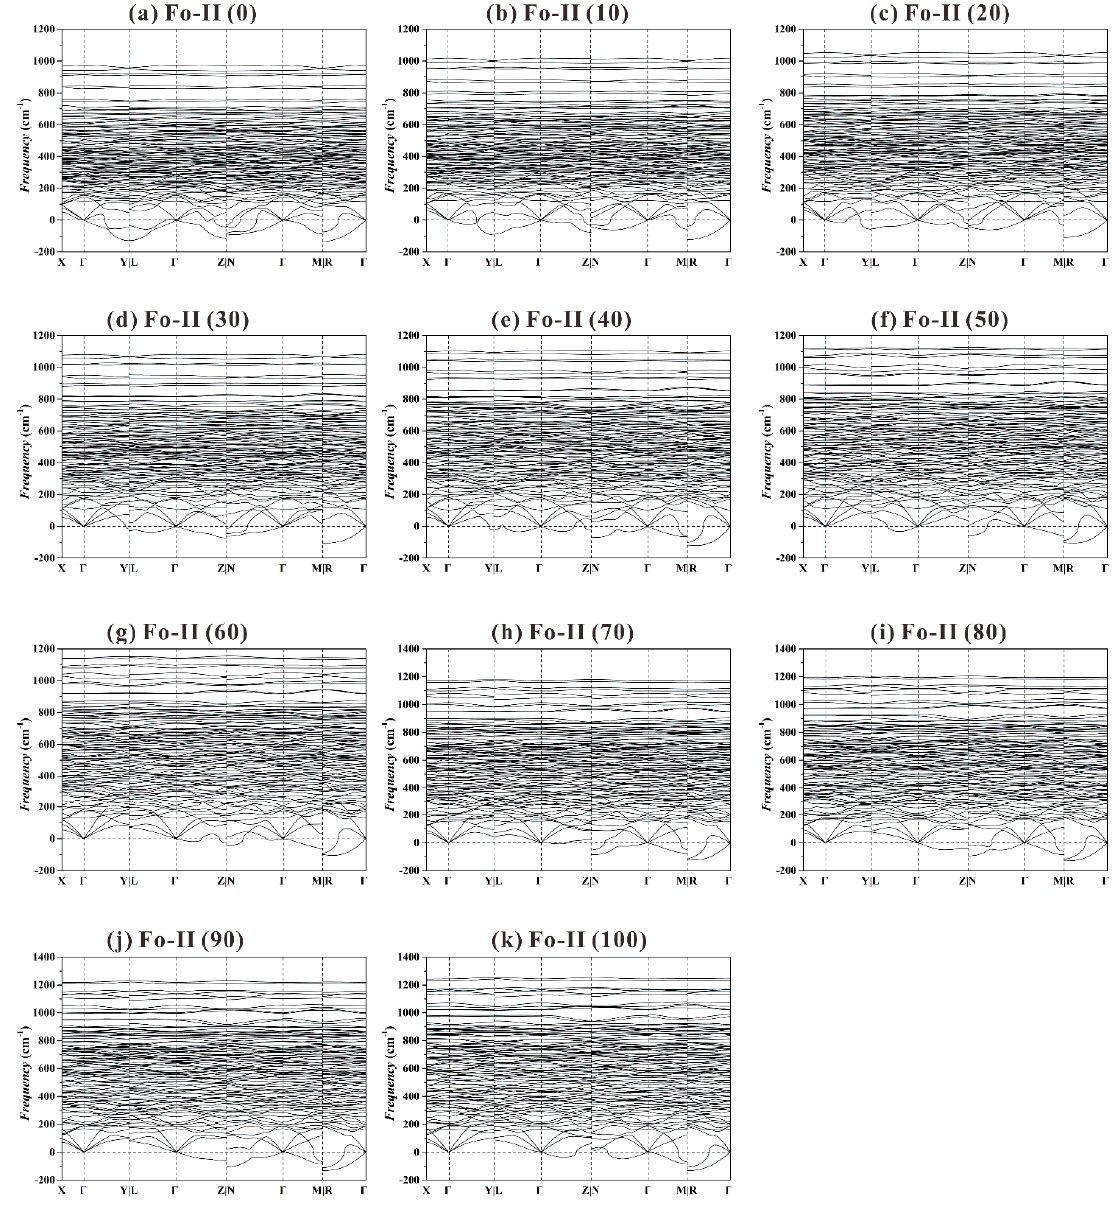
Figure 9. Calculated phonon dispersion curves for Fo-II from 0 to 100 GPa with a k